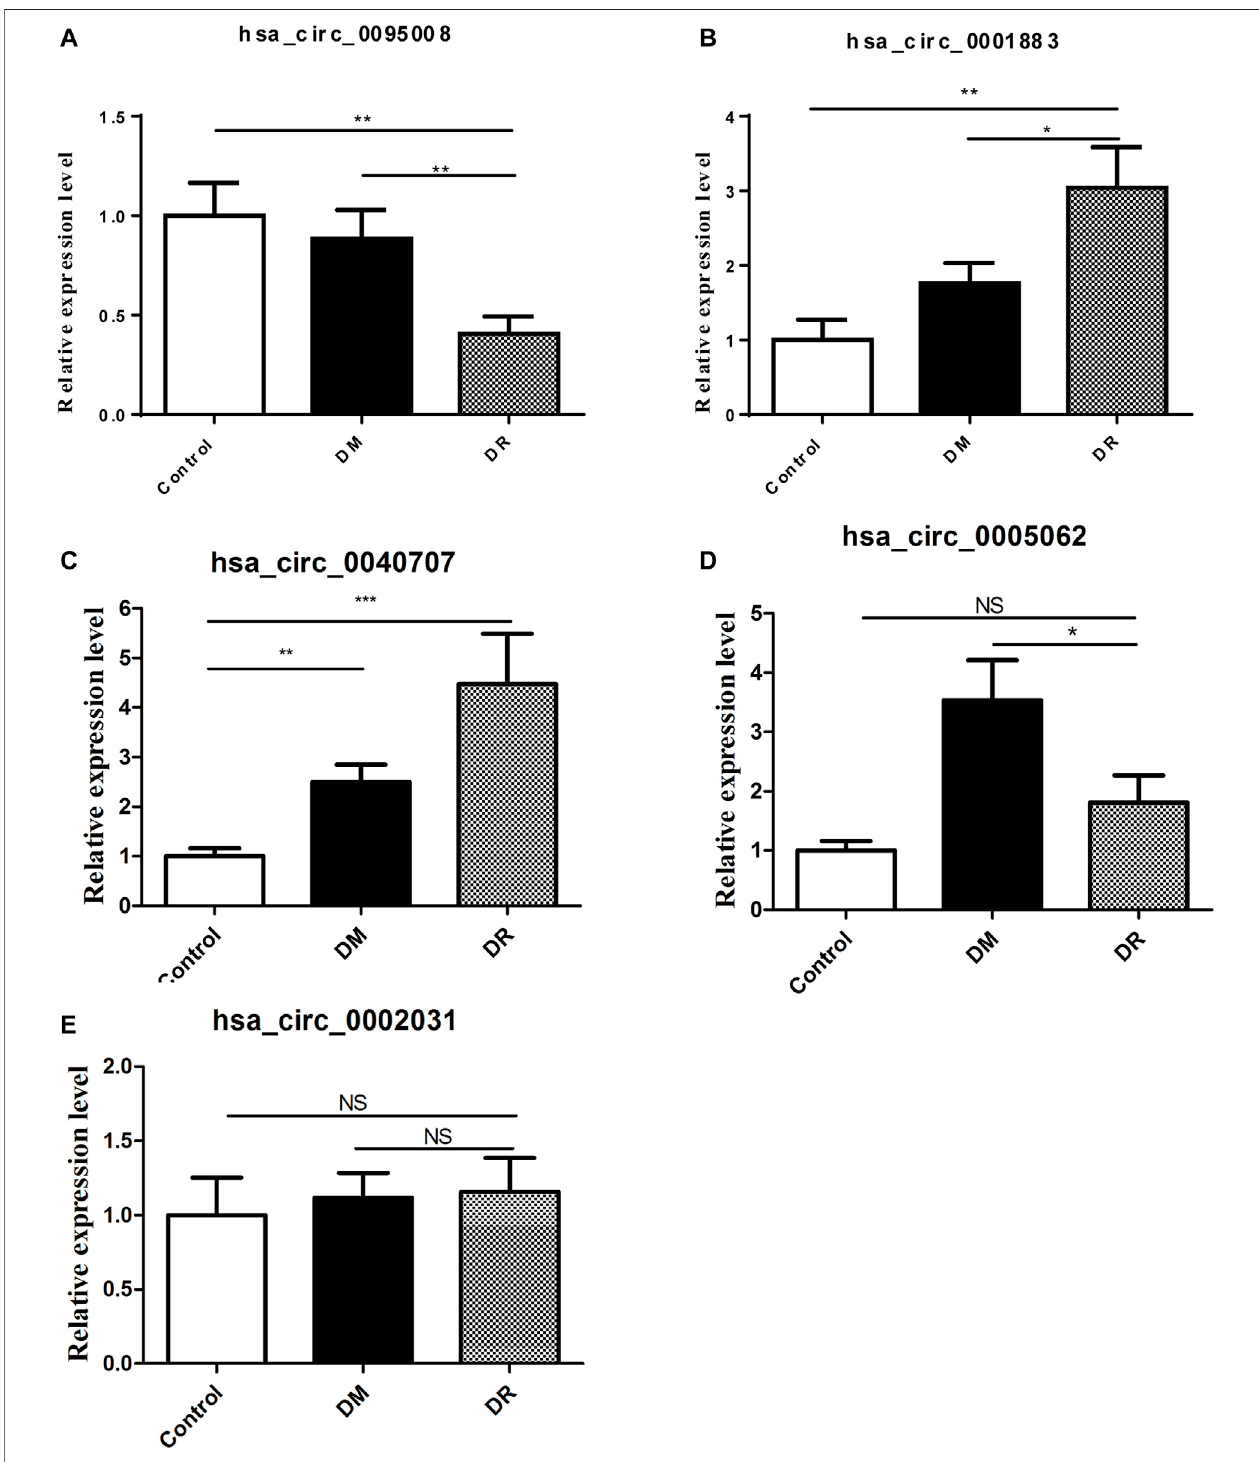
FIGURE 4 | Validation of fi ve candidate circRNAs in DR samples ( n = 42) by RT-qPCR. (A) hsa_circ_0095008; (B) hsa_circ_0001883; (C) hsa_circ_0040707; (D) hsa_circ_0005062; (E) hsa_circ_0002031), compared with DM samples ( n = 60) and controls ( n = 20).* p < 0.05, ** p < 0.01, *** p < 0.001.